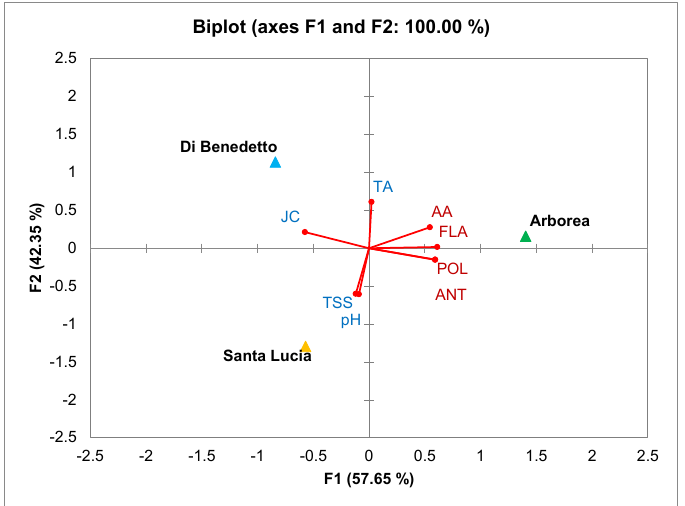
Figure 4. Principal component analysis (PCA) of total polyphenol (POL), antioxidant activity (AA), anthocyanin (ANT) content, flavonoid (FLA) content, juice content (%) (JC), and of qualitative parameters (TSS, TA, and pH) in ‘Santa Lucia’, ‘Di Benedetto’, and ‘Arborea’ pomegranate genotypes.